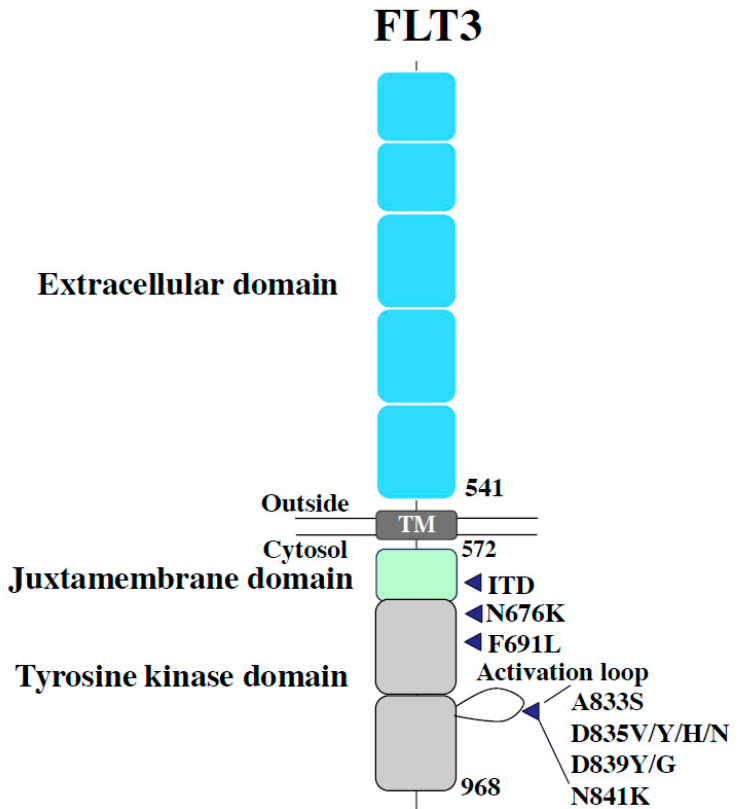
Figure 2. Additional FLT3 tyrosine kinase domain mutations responsible for secondary on-target resistance. These mutations keep the TK domain in active FDG-in form, not allowing the type II inhibitors to bind there. Mutations in a “gate-keeping” residue F691 shows the universal resistance to both type I and II inhibitors.